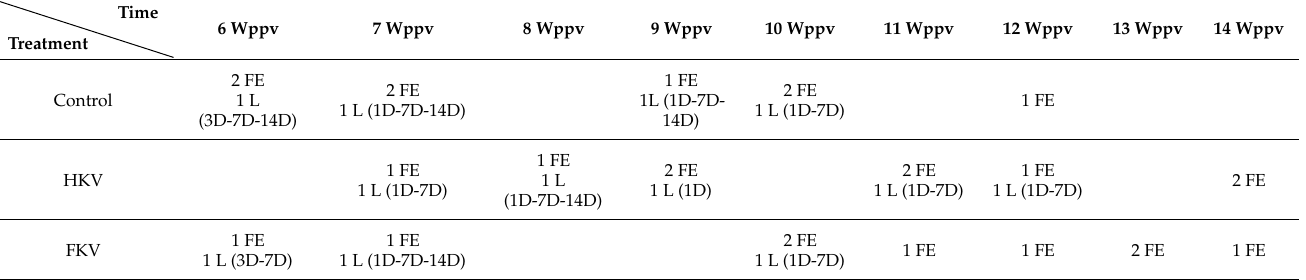
Table 1. Batches of fertilized eggs and larvae were collected at different time points post-primary